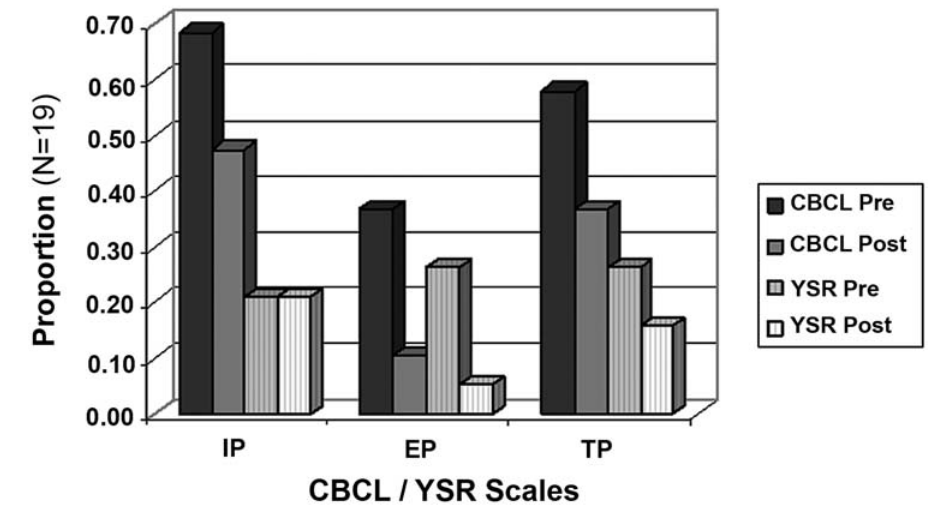
Figure 1 – Proportion of adolescents within clinical range (pre and post treatment data) according to parents’ reports on CBCL and to youths’ reports on YSR. IP = Internalizing Problems Scale; EP = Externalizing Problems Scale; TP = Total Problems